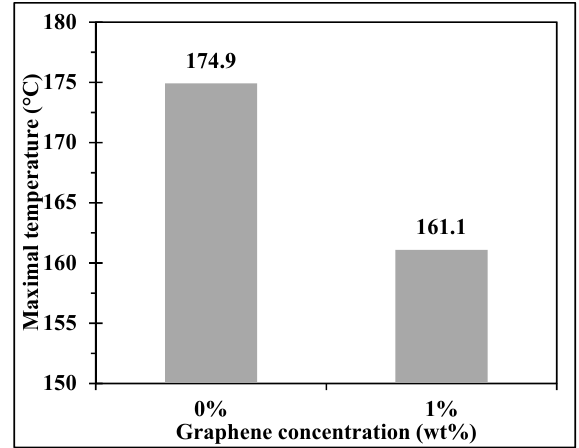
Figure 12. Maximal cutting temperatures.